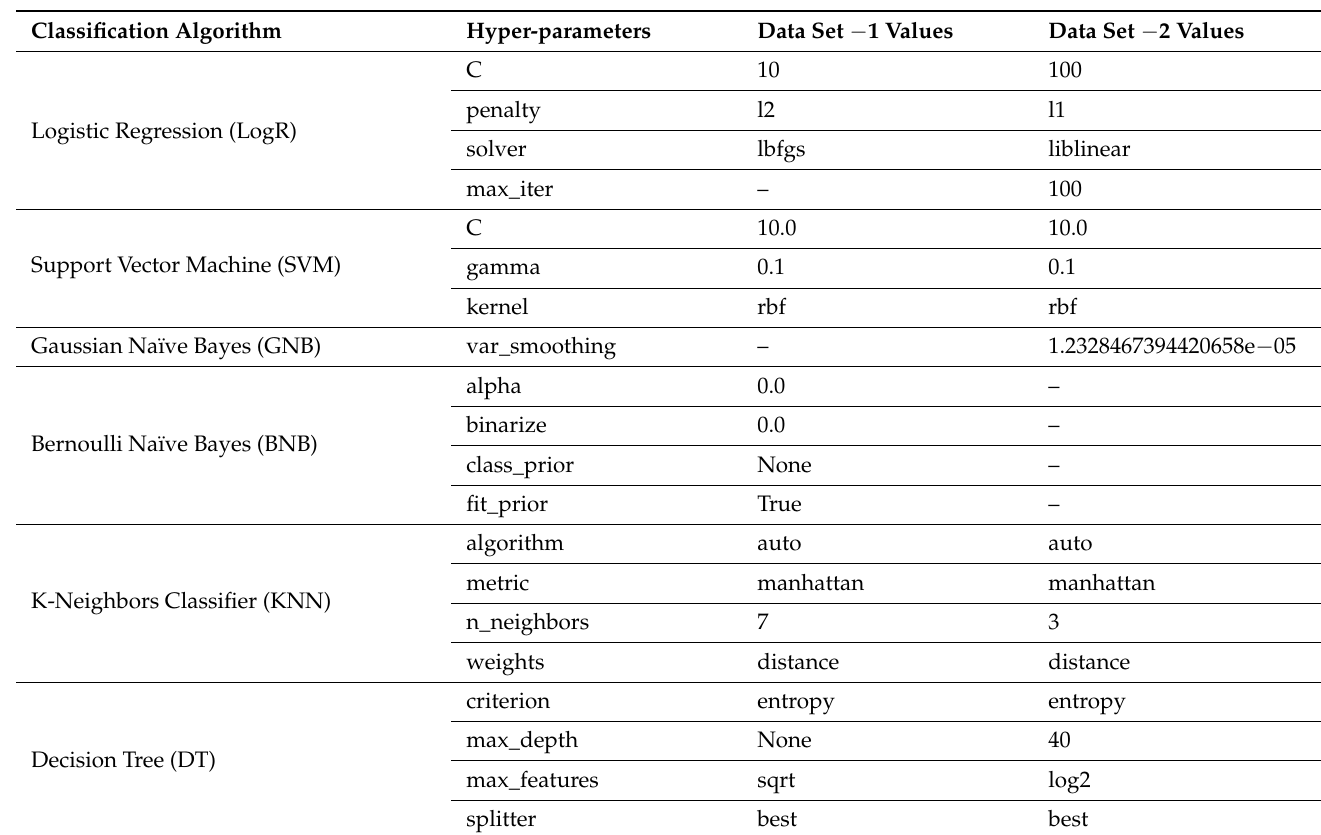
Table 10. Hyper-parameters for classification